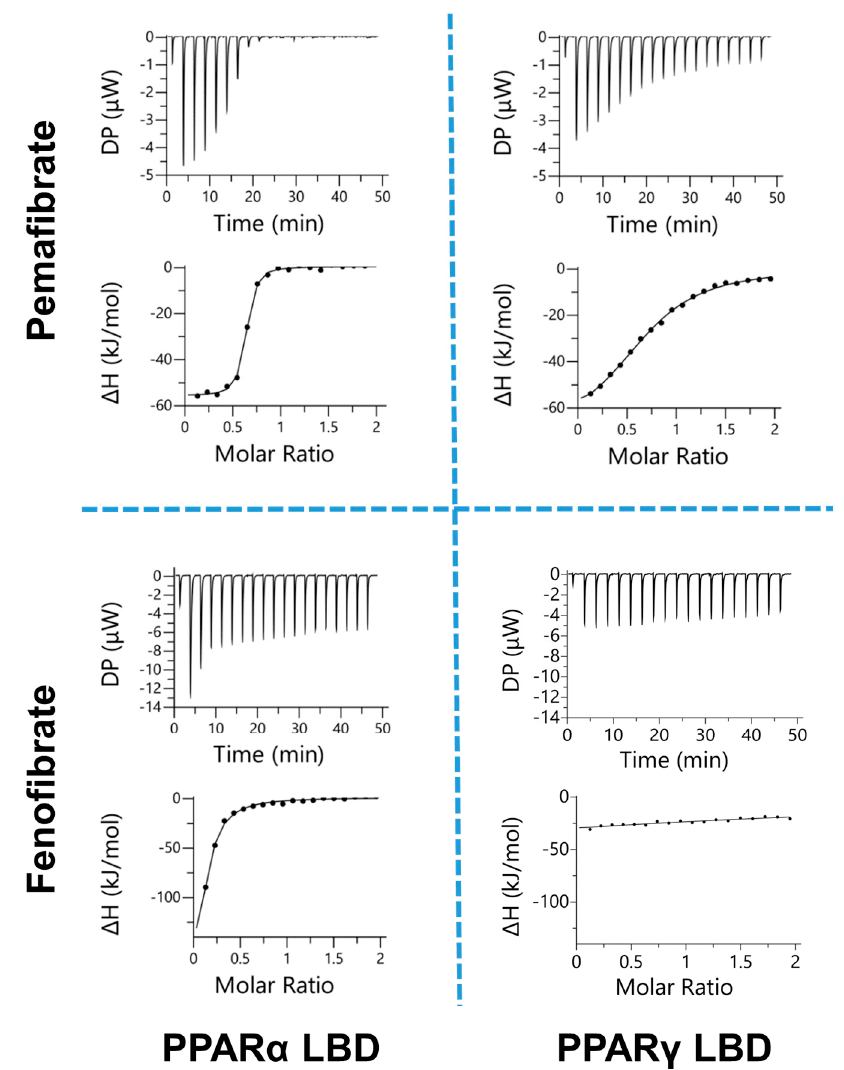
Figure 1. Isothermal titration calorimetry (ITC) analysis of fenofibric acid and pemafibrate binding to peroxisome proliferator activated receptor α (PPAR α ) and PPAR γ ligand binding domain (LBD). The upper and lower panels of ITC data represent the heat signal generated by the binding of each ligand to PPARs in the cells and integration of the signal per injection, respectively. All the relevant parameters are given in Table 1.